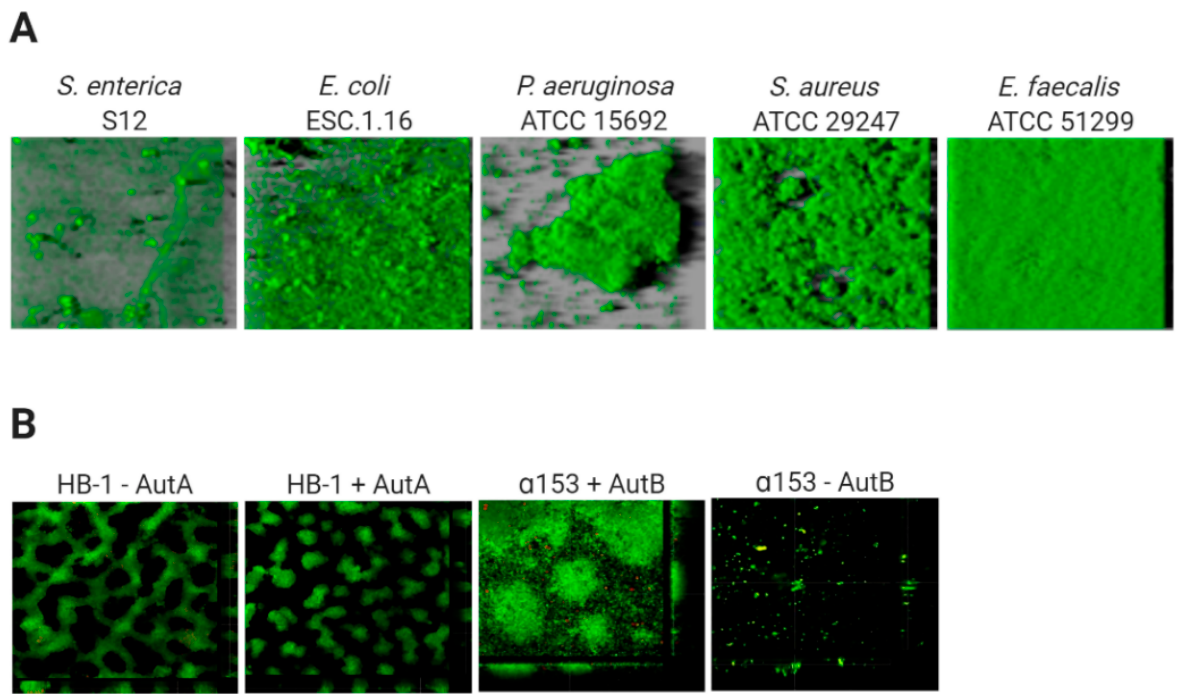
Figure 1. Variable architecture of biofilms. ( A ) Biofilms of five species ( Salmonella enterica , Escherichia coli , Pseudomonas aeruginosa Staphylococcus aureus , Enterococcus faecalis) were formed under static conditions on abiotic surfaces during 24 h and were stained with Syto9, a green fluorescent nucleic acid marker. Reprinted from [51] with permission from Elsevier. ( B ) Strains of Neisseria meningitidis HB-1 and α 153 and derivatives, which do or do not produce the autotransporters AutA and AutB (as indicated), formed biofilms under flow conditions during 14 h and were stained with the LIVE/DEAD Backlight bacterial viability stain (where red cells are dead and green cells are live). Reproduced from [52,53].